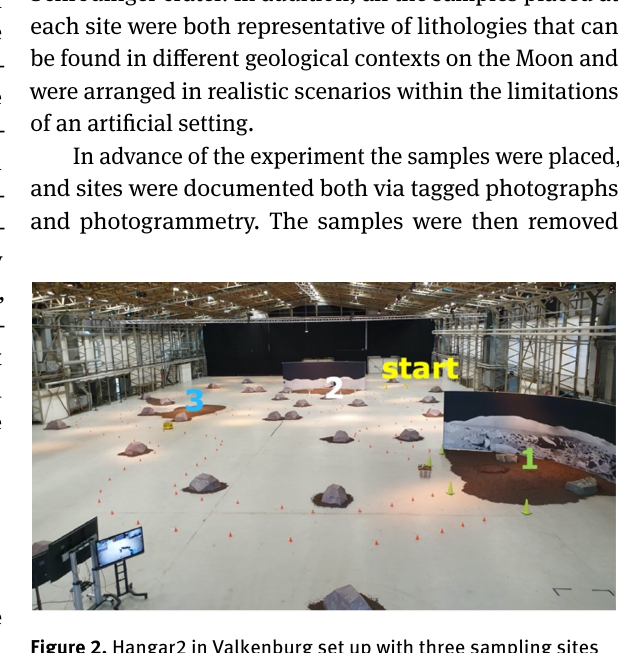
Figure 2. Hangar2 in Valkenburg set up with three sampling sites and a 150-metre long